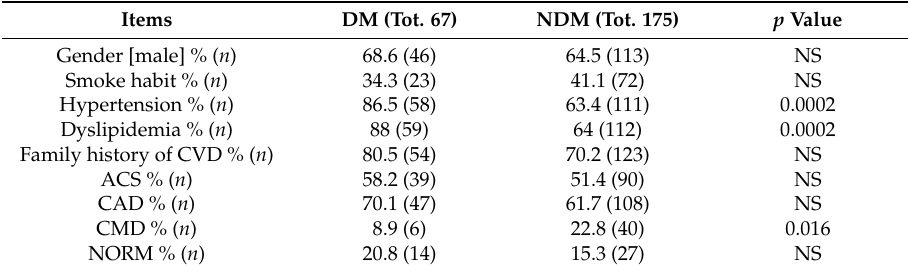
Table 1. Baseline data of